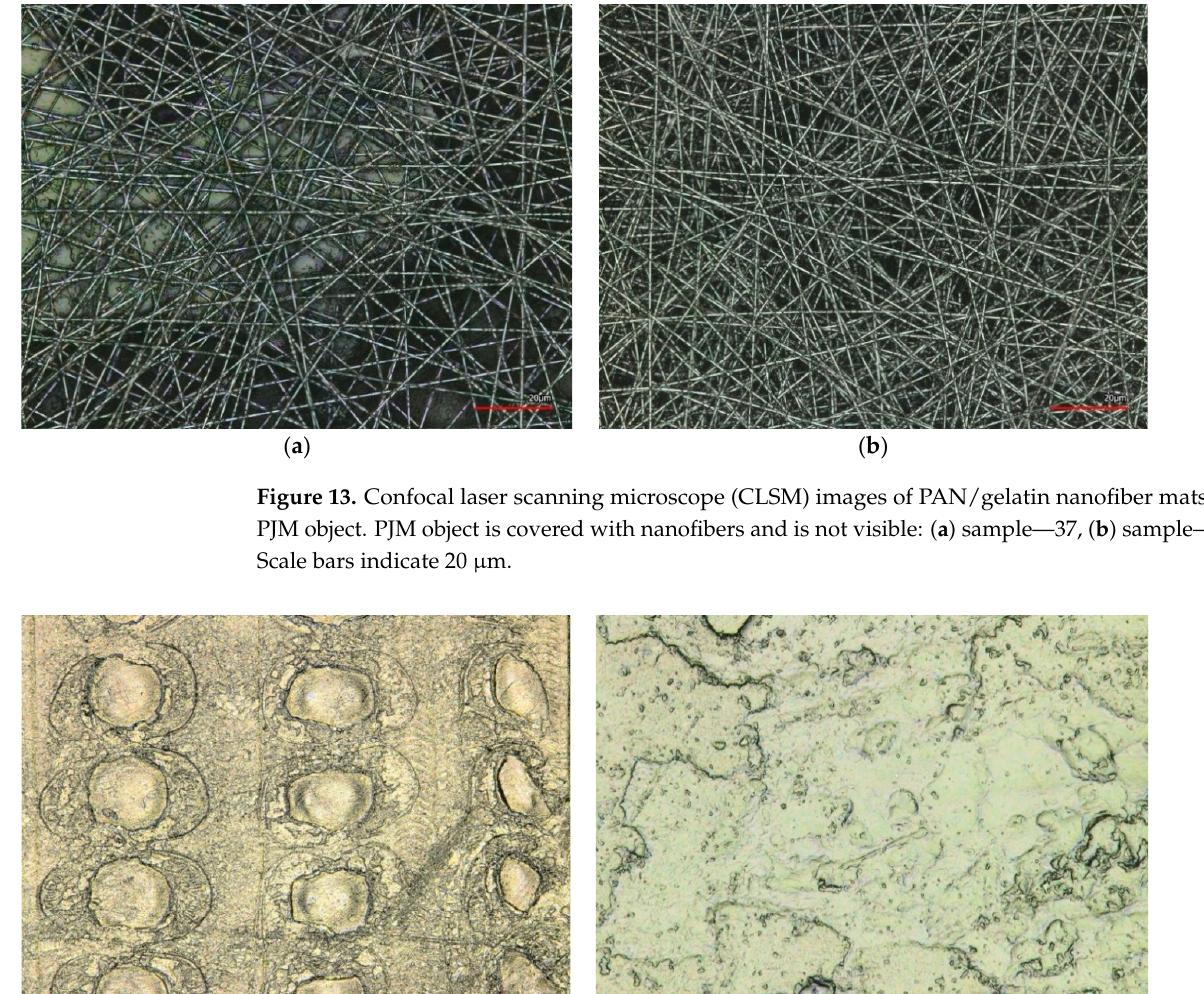
Figure 12. Confocal Laser Scanning Microscope (CLSM) image of PLA object, sample—7. Scale bar indicates 200 µ m.